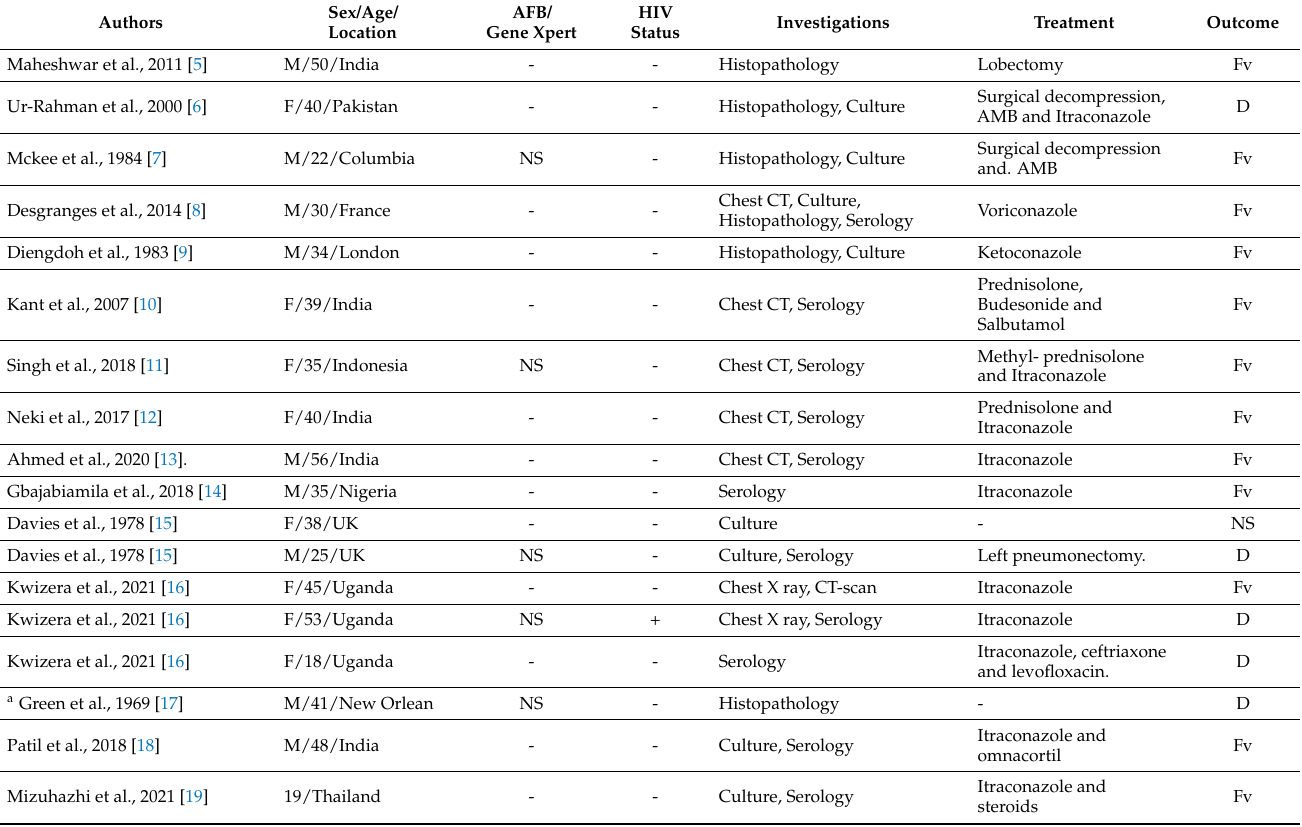
Table 2. Cases of aspergillosis misdiagnosed as